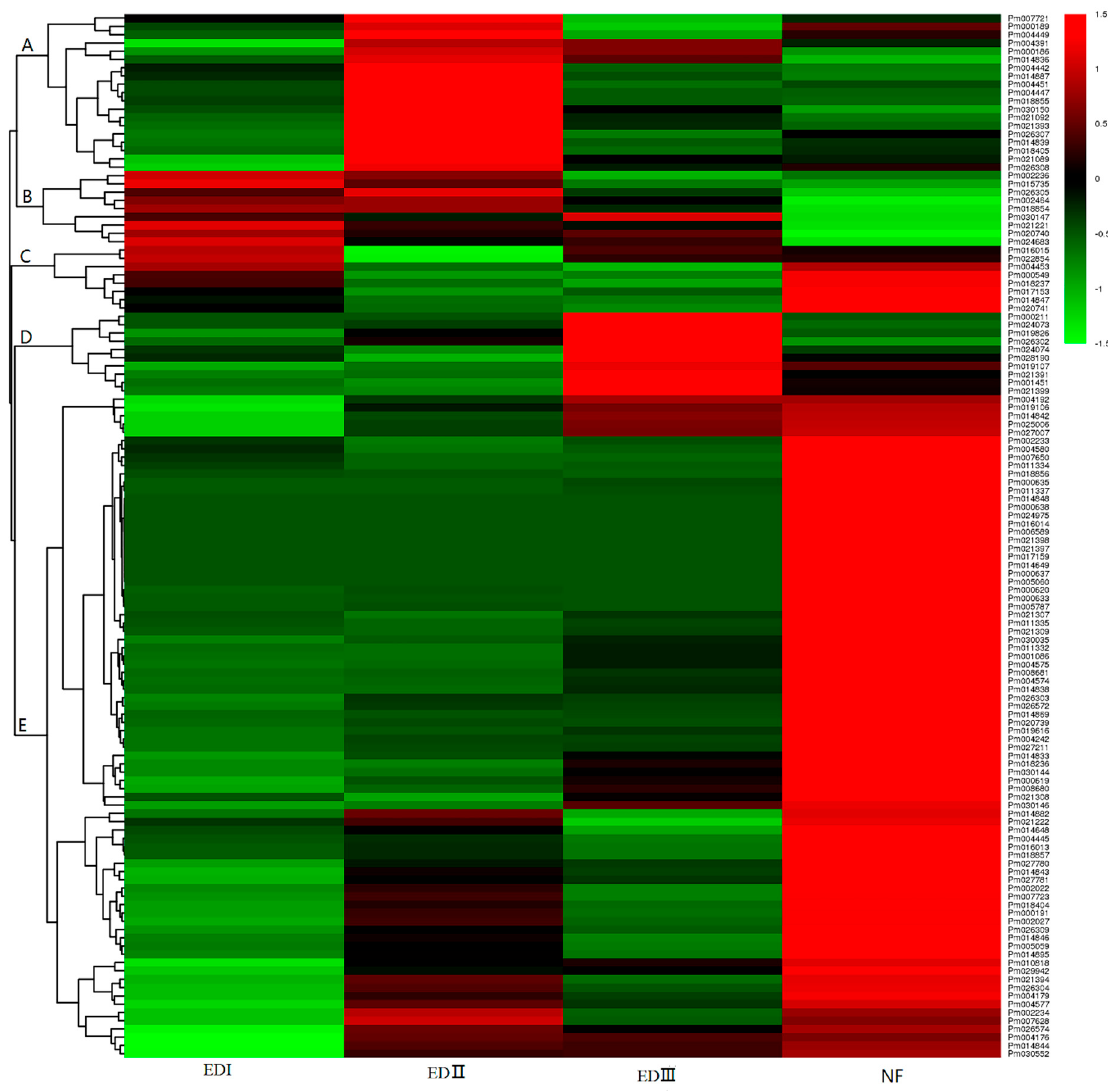
Figure 6. Expression profiles of PmUGTs at different dormancy stages. The scale represents signal intensity of FPKM values. EDI, EDII, EDIII and NF represented four dormancy stages. Red indicates high relative gene expression and green indicates low relative gene expression. Letters assigned to major clusters are indicated on the dendrogram.